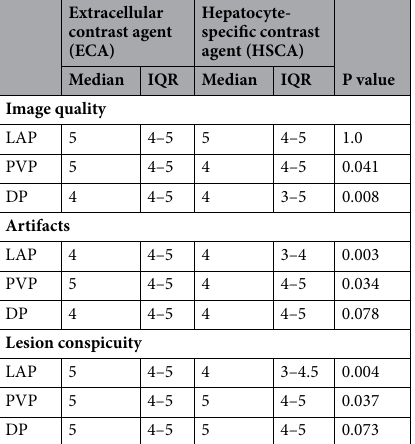
Table 2. Qualitative analysis of overall image quality, artifacts, and lesion conspicuity for both contrast agents and throughout the different perfusion phases. LAP late arterial phase, PVP portal venous phase, DP delayed phase